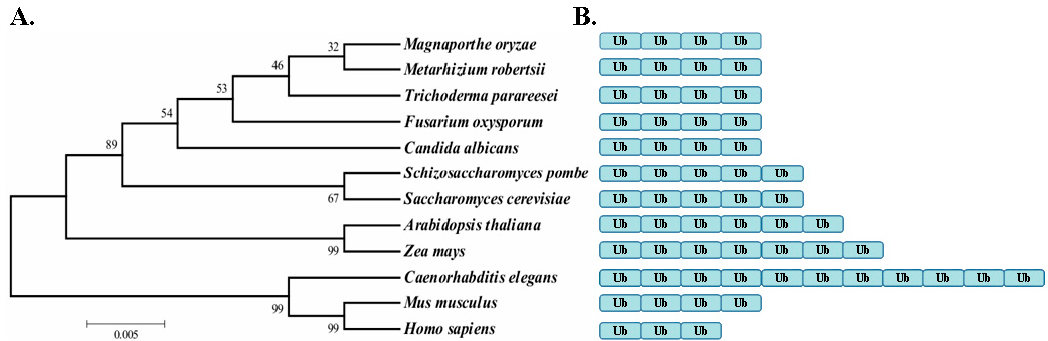
Figure 1. Phylogenetic analysis of MrUBI4 and the polyubiquitin orthologs from various fungi, plants, and animals. (A) The phylogenetic tree was generated via the MEGA7 software using default settings (neighbor-joining method). The amino acid sequences of polyubiquitin that were used in this analysis are as follows: Magnaporthe oryzae (EHA54394.1), Metarhizium robertsii (MAA_02160), Trichoderma parareesei (OTA03154.1), Fusarium oxysporum (ENH62031.1), Candida albicans (CAA90901.1), Arabidopsis thaliana (CAB81074.1), Saccharomyces cerevisiae (YLL039C), Schizosaccharomyces pombe (SPBC337.08c), Zea mays (NP_001316595.1), Caenorhabditis elegans (F25B5.4/WBGene00006727), Mus musculus (MGI:98888), and Homo sapiens (ENSG00000170315). (B) The variant number of monomeric ubiquitin repeats in the polyubiquitin protein of different species. Box with Ub in blue represents 1 monomeric ubiquitin repeat.